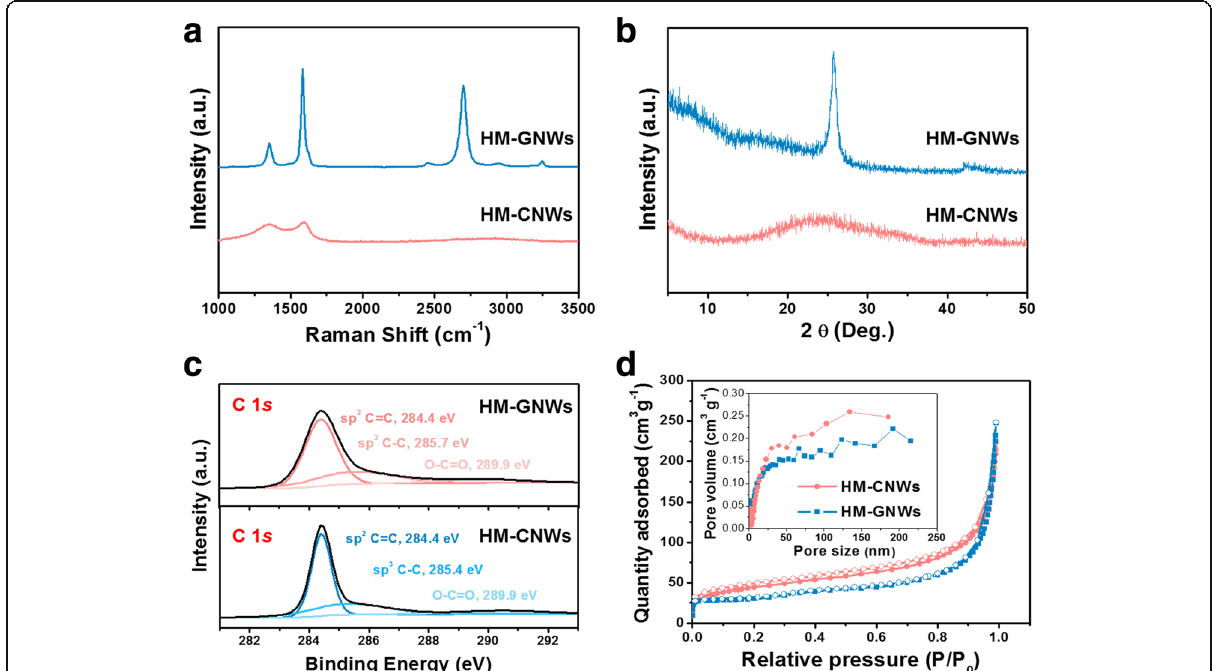
Fig. 2 a Raman spectra, b XRD patterns, c XPS C 1s spectra, and d nitrogen adsorption and desorption isotherm curves (inset of pore size distribution data) of HM-CNWs and